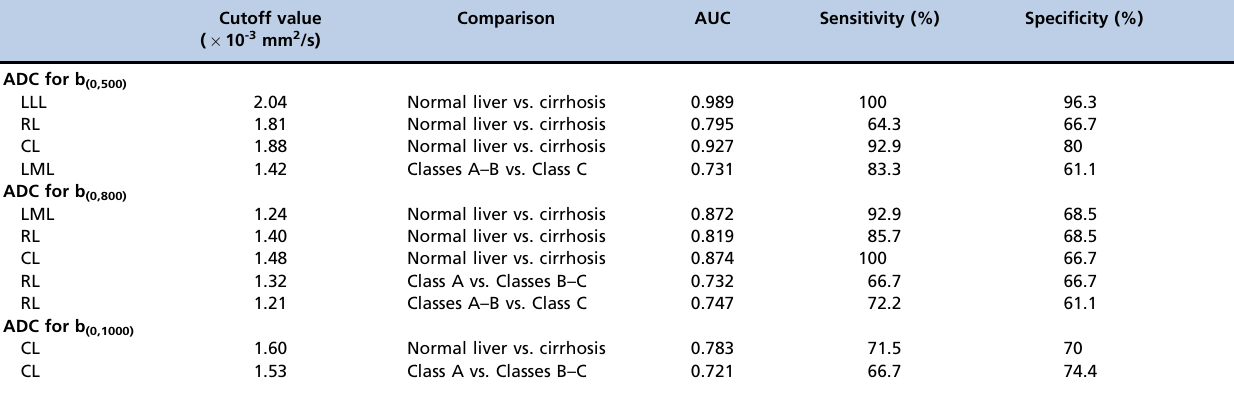
Table 5 - Receiver operating characteristic analysis of liver lobe-based apparent diffusion coefficients for determining the Child-Pugh class of